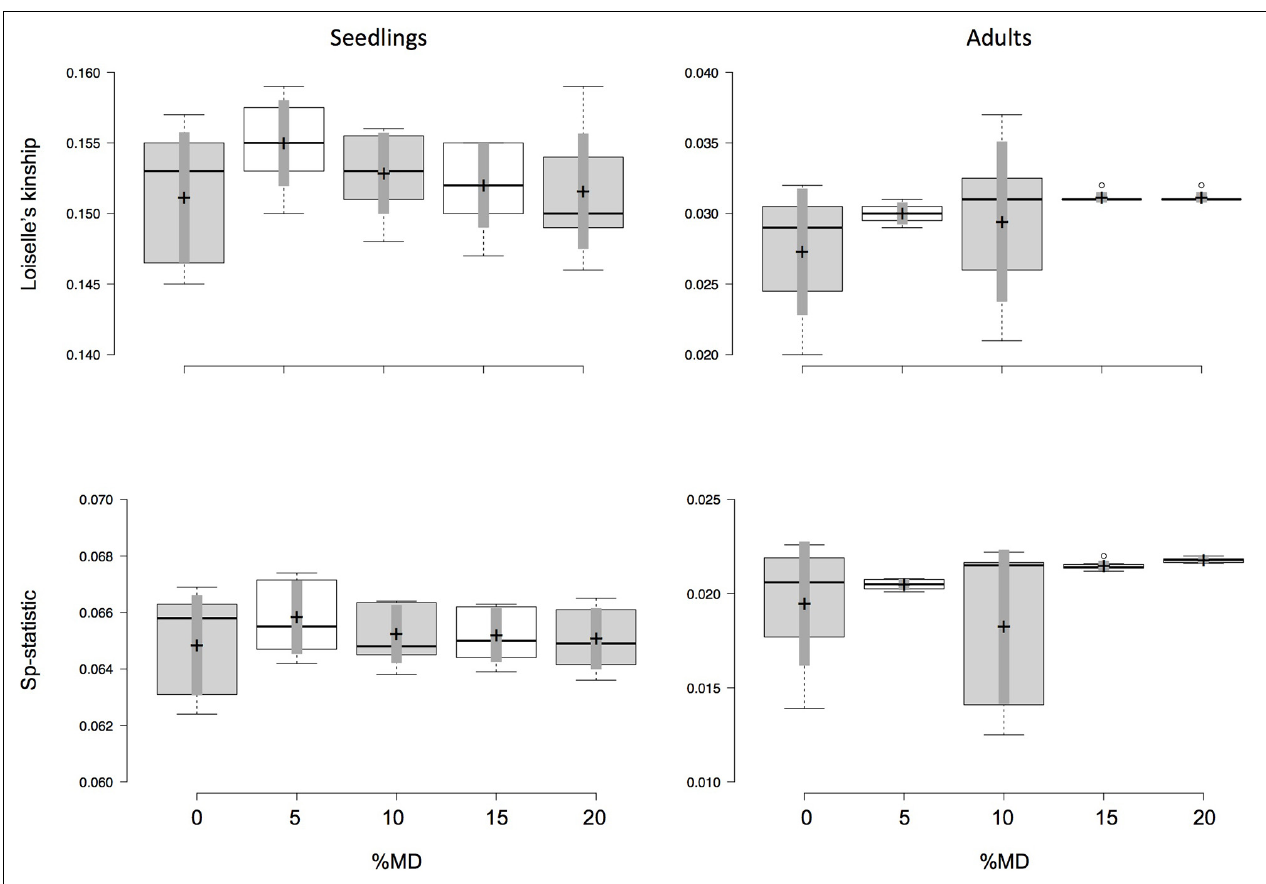
FIGURE 3 | Effect of missing data (MD) and minor allele frequency (MAF) on values of Loiselle’s kinship measure for the first distance class ( F 1 ), which is less than 55 m between seedling and putative parent, and its derivative Sp -statistic for seedlings (left column) and adults (right column) of Dinizia jueirana-facao . The amount of MAF varied from 0.05 to 0.35 (i.e., seven data sets) for each fixed percentage of MD. Boxplots show the median (center line) and mean (marked by cross, with 95% confidence in gray) of F 1 and Sp -statistic, and the 25th and 75th percentiles (by the box) with the extent of the whiskers marking 1.5 times the interquartile range from the 25th and 75th percentiles, and outliers (marked by dots), as calculated using R software.